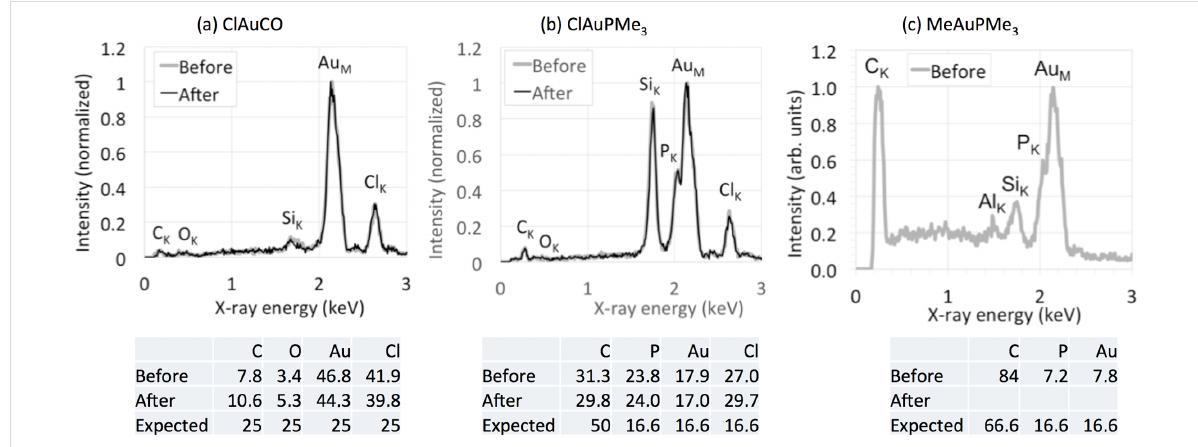
Figure 7: Compositional analysis of Au(I) complexes using EDS. (a) For ClAuCO the Au/Cl ratio was about 1:1, and little C and O was detected. (b) For ClAuPMe 3 approximately the correct stoichiometry was detected, both before and after 12 h in vacuum. (c) For MeAuPMe 3 more C was detected than expected, which we attribute to remnants of silicone grease used during the